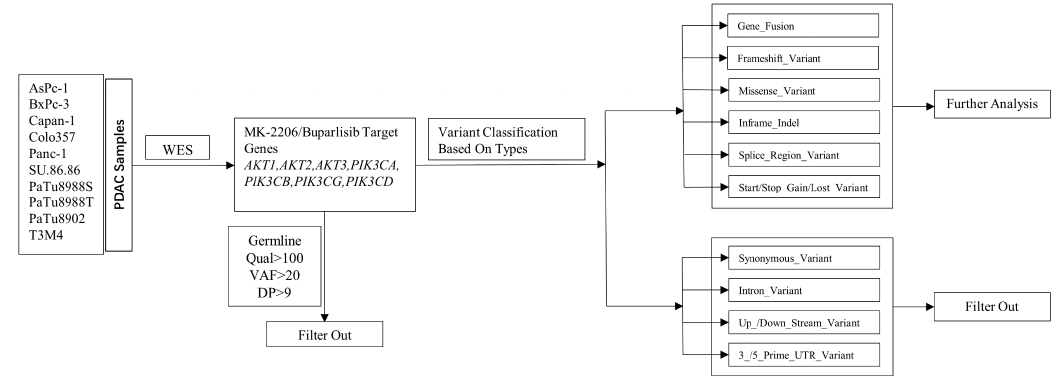
Figure 7. Filtering strategy of MK-2206 and Buparlisib target genes.